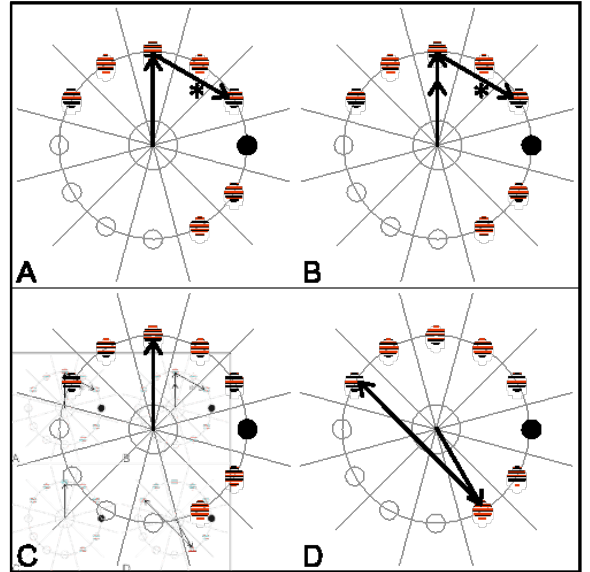
Figure 4. Examples of included and excluded trials. A. Accepted second saccade (*) in a normal trial. B. Accepted third saccade (*) after a refixation. C.